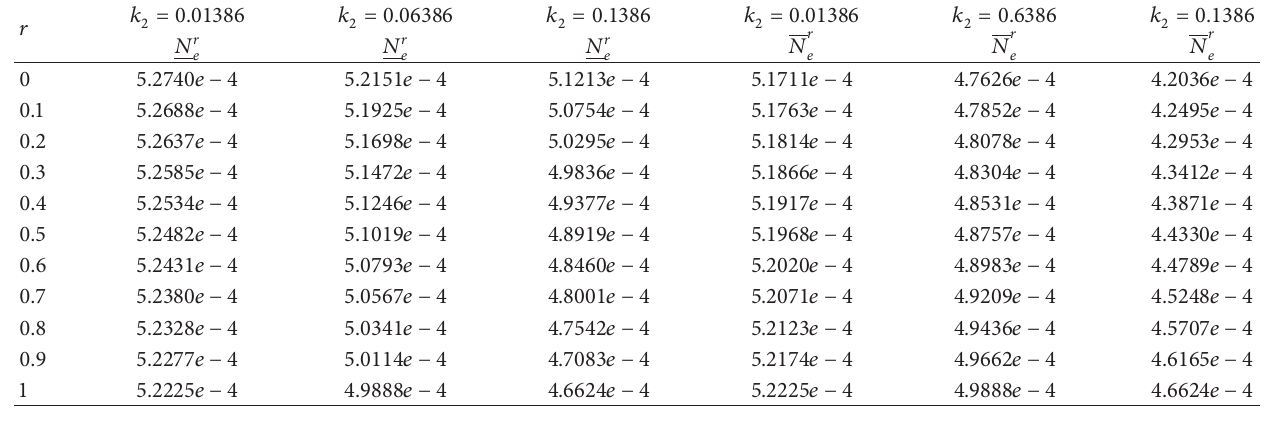
Table 3: The results of the proposed method for Case II with V = 0.95 , 𝛼 = 𝛽 = 0.5 , and 𝑁 = 7 .